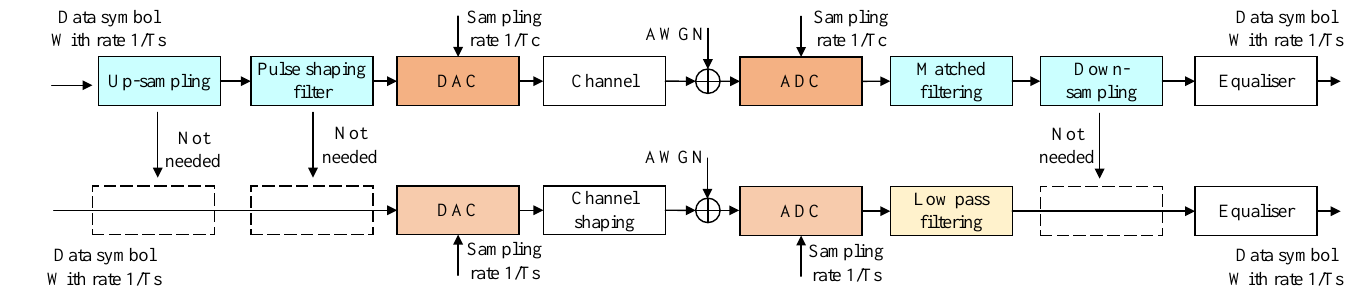
Figure 1. Conventional pulse shaping system (upper) and full Nyquist rate system